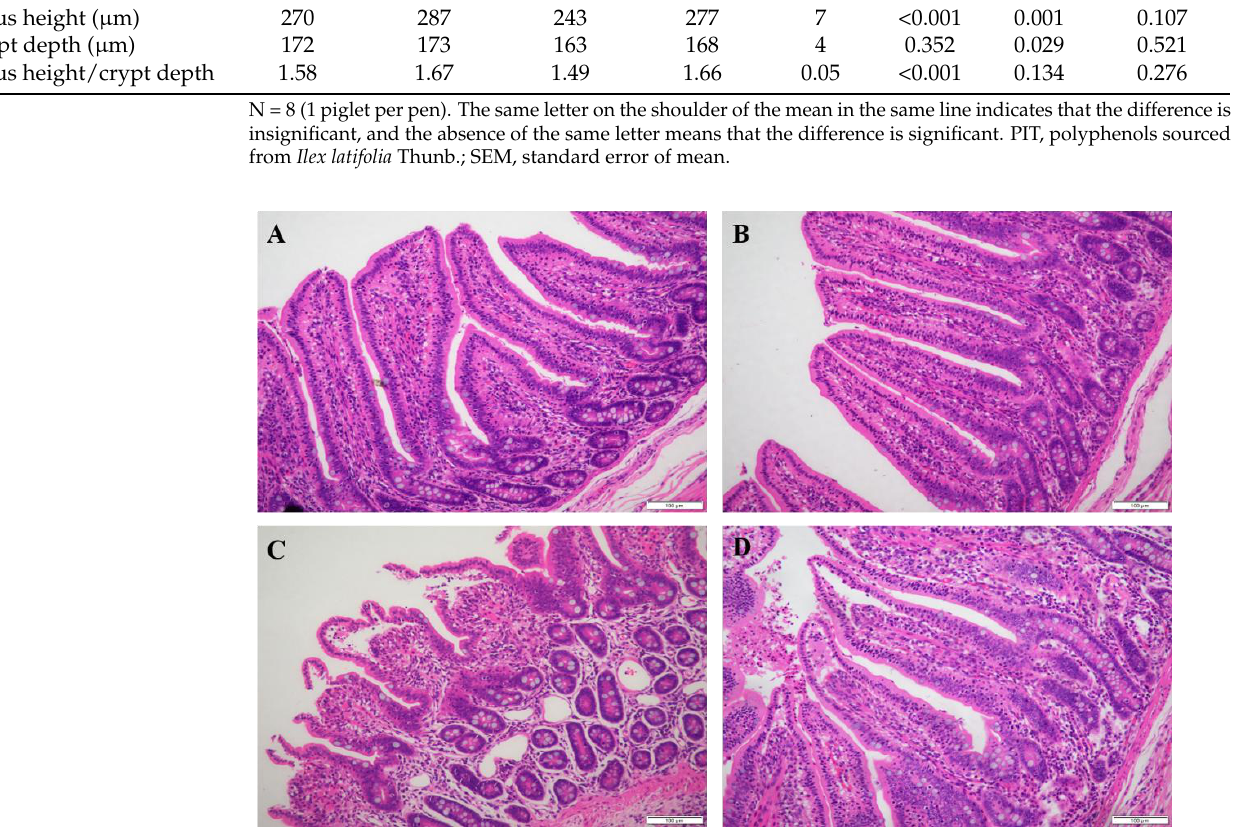
Figure 2. Ileal mucosal histological appearance (hematoxylin and eosin) of the piglets fed polyphenols sourced from Ilex latifolia Thunb. (PIT) diets under oxidative stress. Original magnification 200×. Scale bars = 100 μm. ( A ) Piglets fed the basal diet and treated with saline. ( B ) Piglets fed the PIT diet and treated with saline. ( C ) Piglets fed the same basal diet and treated with diquat. ( D ) Piglets fed the same PIT diet and treated with diquat.